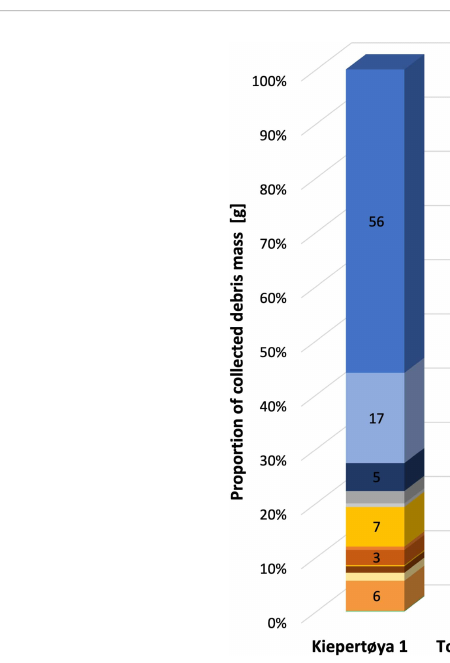
FIGURE 4 Detailed composition of beach debris categories (%) based on mass [g]. (n.d. = not de fi ned, m = metal, p =